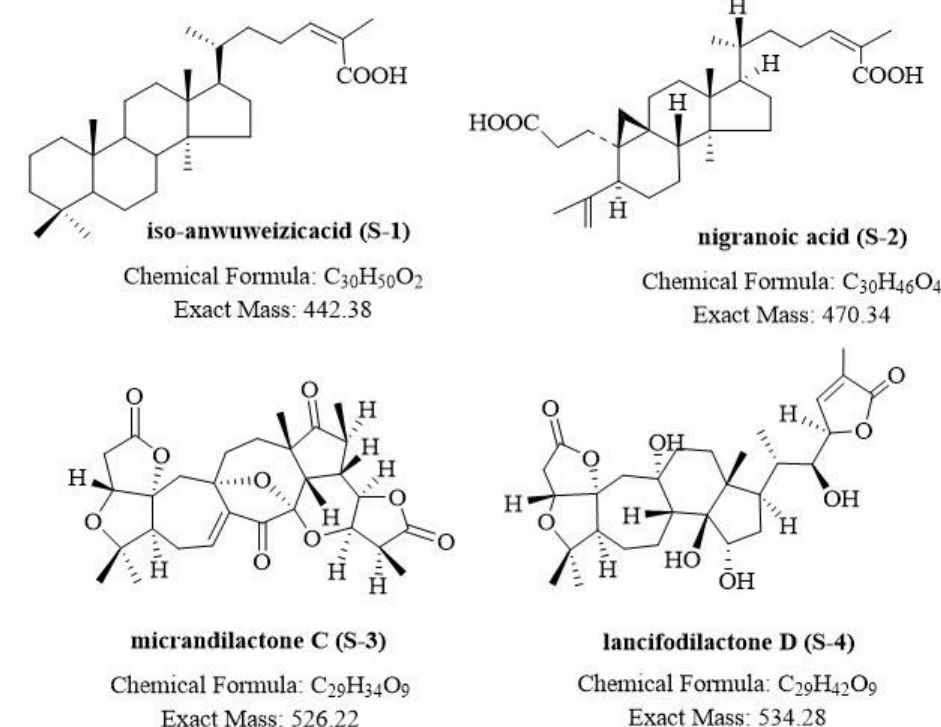
Figure 1. Structures of Schitriterpenoids and